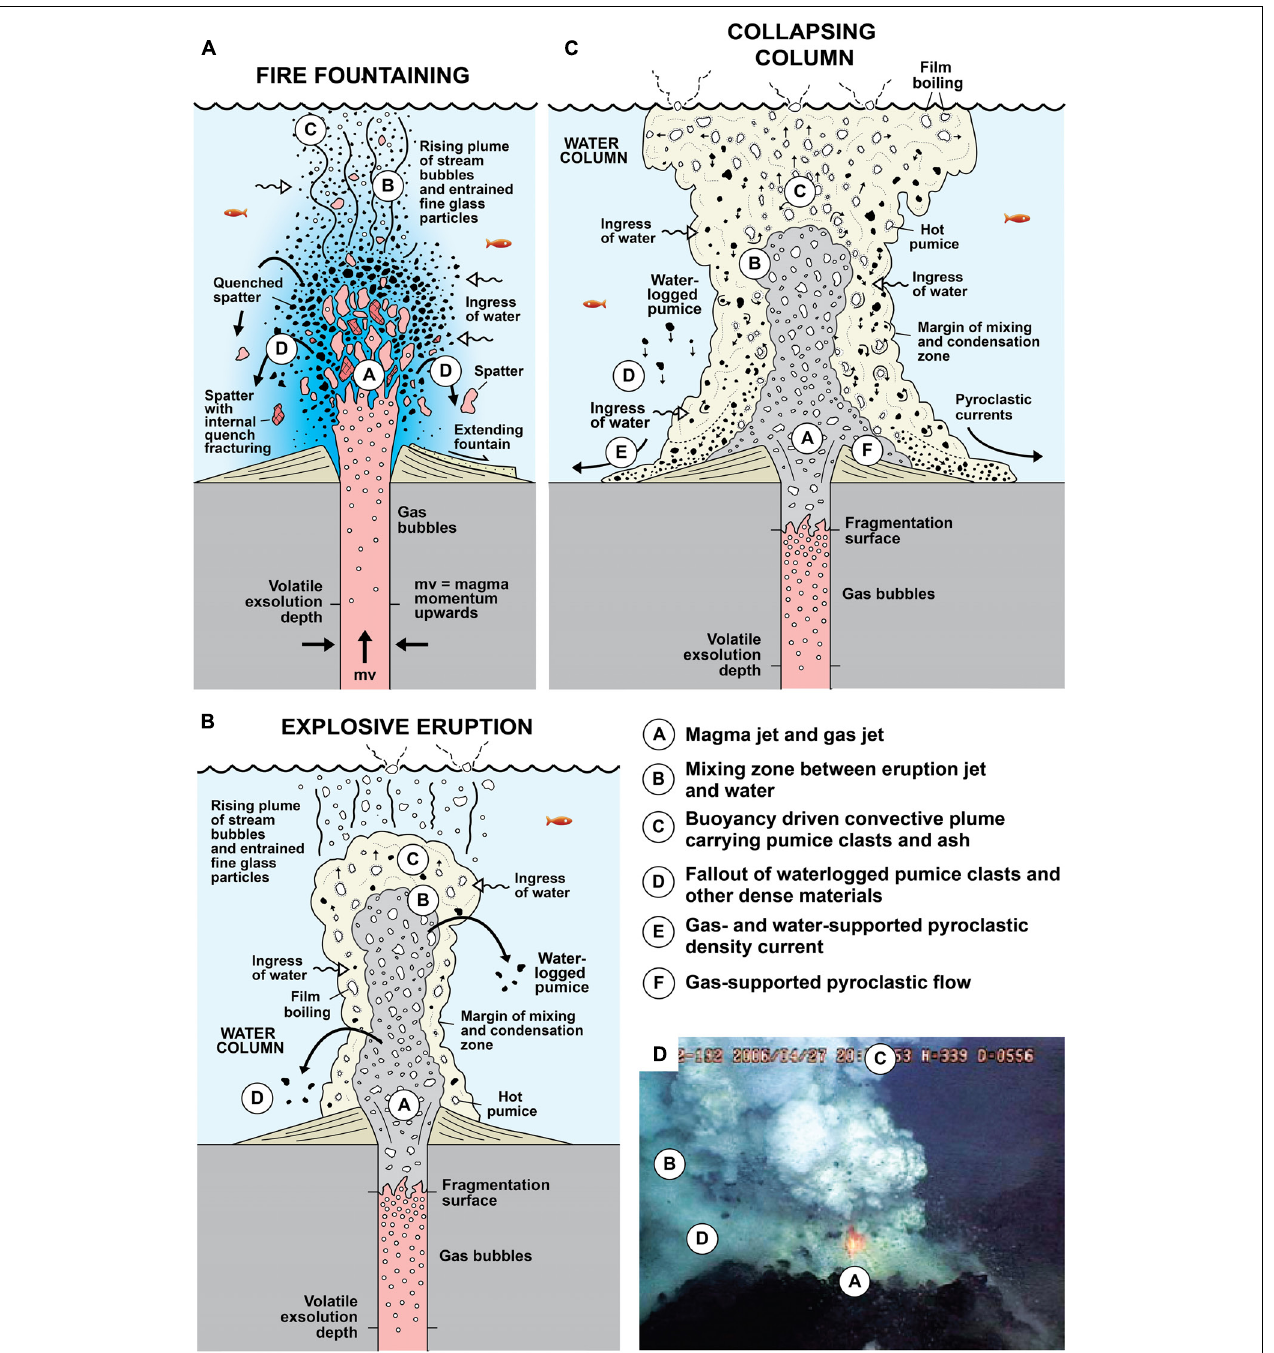
FIGURE 8 | Subaqueous eruption column characteristics. (A) Deep-water fire fountain column, showing quench fragmentation of spatter clasts in the column and the water mass above the vent. (After Cas et al., 2003, Figure 14A, under rights granted to authors by American Geophysical Union https://publications.agu.org/author-resource-center/usage-permissions/). (B) Complex processes contributing to the dynamics of a relatively deep-water, subaqueous explosive eruption column as a result of initial bubble decompression and expansion, then cooling, condensation and water ingress into a subaqueous eruption column upward. (C) Schematic diagram of a relatively shallow water (tens to hundreds of meters) explosive eruption column collapsing around the vent. The rising buoyant column is subject to condensation of gasses and mixing in of ambient water. Large pumice clasts become water-logged, contributing to collapse of the column, forming a hot mass-flow of pyroclastic debris, steam and water on the seafloor. (After Kano et al., 1996, Figure 12; Permission from Elsevier). (D) Small, suppressed explosion of small ejecta, with a core of incandescent lava or fire fountain, in 2006, Brimbank Crater, NW Rota 1 volcano, Marianas arc, water depth ∼ 550 m. (From Chadwick et al., 2008, Figure 9E , under usage permissions for academic works policy of the American Geophysical Union https://publications.agu.org/author-resource-center/usage-permissions/).